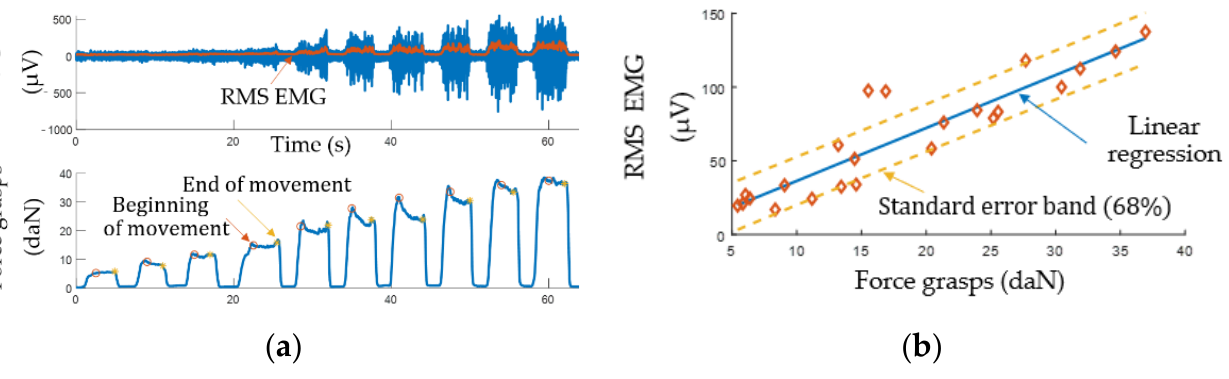
Figure 10. EMG signal analysis: ( a ) experimental data; ( b ) RMS EMG vs. force.